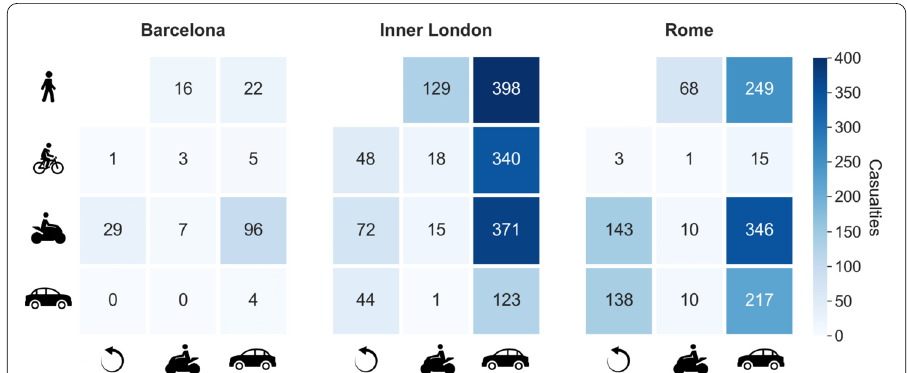
Figure 2 Casualty matrices for Barcelona, Inner London and Rome demonstrate heterogeneity of road traffic risks. The casualty matrix shows the number of killed or seriously injured people in 2018 after a traffic participant on the left collided with one on the bottom. The leftmost column (above the symbol (cid:2) ) denotes a crash with only one participant, indicating self-risk. The heterogeneity of posed risks is apparent: Cars are responsible for the majority of road deaths/injuries, while columns for pedestrians and cyclists do not appear because they pose practically no risk to others. Further, these examples also reveal the heterogeneity of risks to specific vulnerable participants through different cities, for example a much higher relative risk to pedestrians in London than in Barcelona. See Fig. S1 for a full picture including more traffic participants and all studied